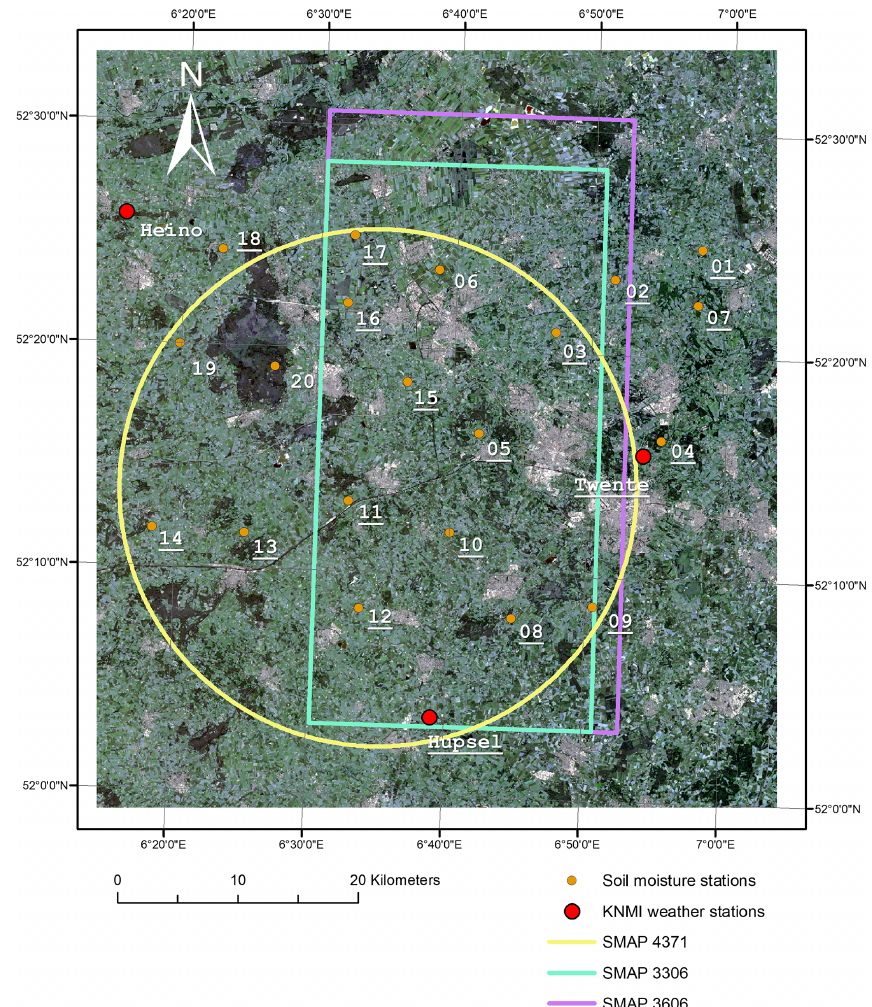
Figure 2. Delineation of the SMAP reference pixels 4371, 3306, and 3606 and the locations of the UT-ITC soil monitoring and the KNMI weather stations lain over a Landsat 8 true colour composite of 20 July 2013 (image courtesy of the U.S. Geological Survey). Double digits indicate the soil moisture station ID and names (Heino, Hupsel, Twenthe) refer to the weather stations. Stations with underlined ID numbers are still operational. Coordinates are given in latitude/longitude (datum: